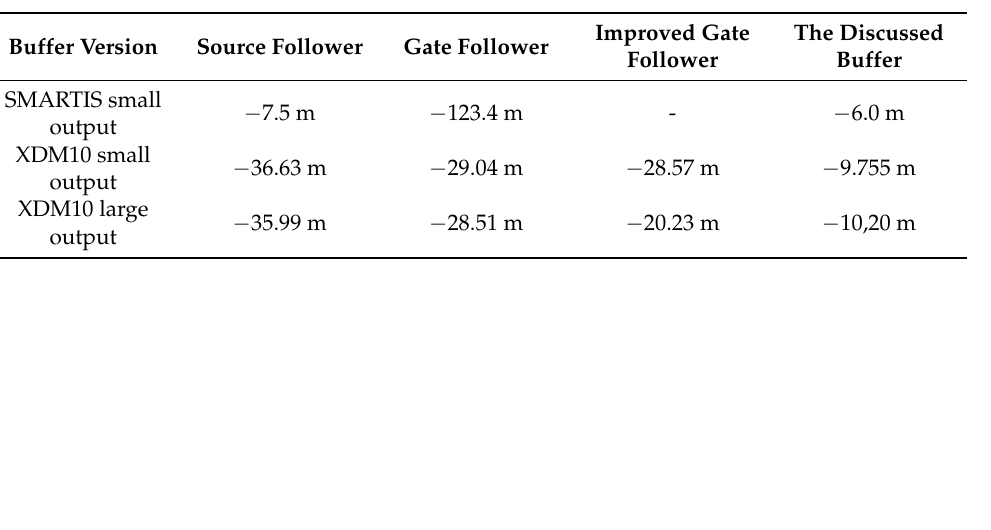
Table 2. Comparison of output–input DC offset [V] for different schematic stage implementations of the source follower, gate followers, and discussed